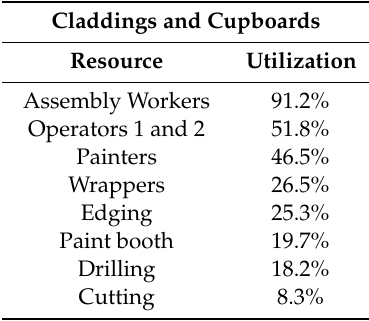
Table 7. Utilization of